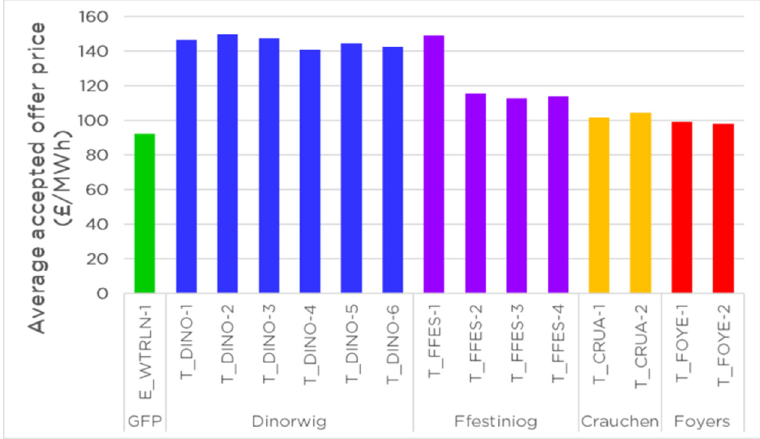
Figure 3. Accepted offer price [27].